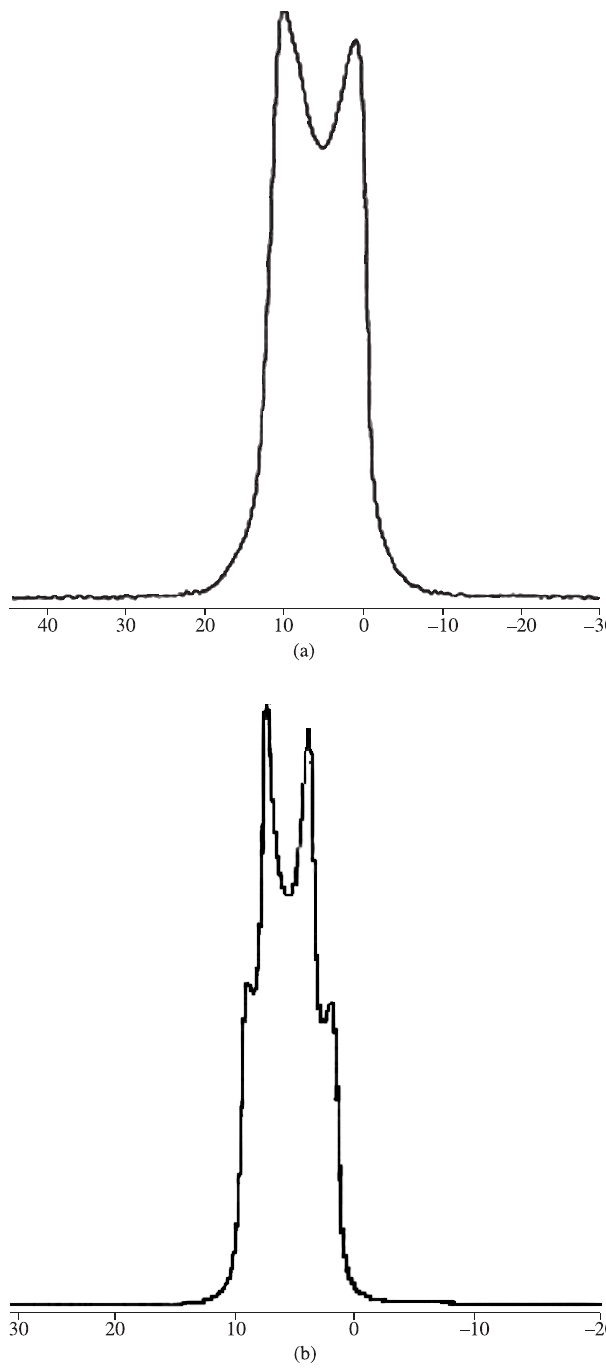
Figure 2. 2H -NMR spectra for liquid crystal phases with a) Renex-60 TM and b) Renex-100 TM . Both phases were enriched with 5% D